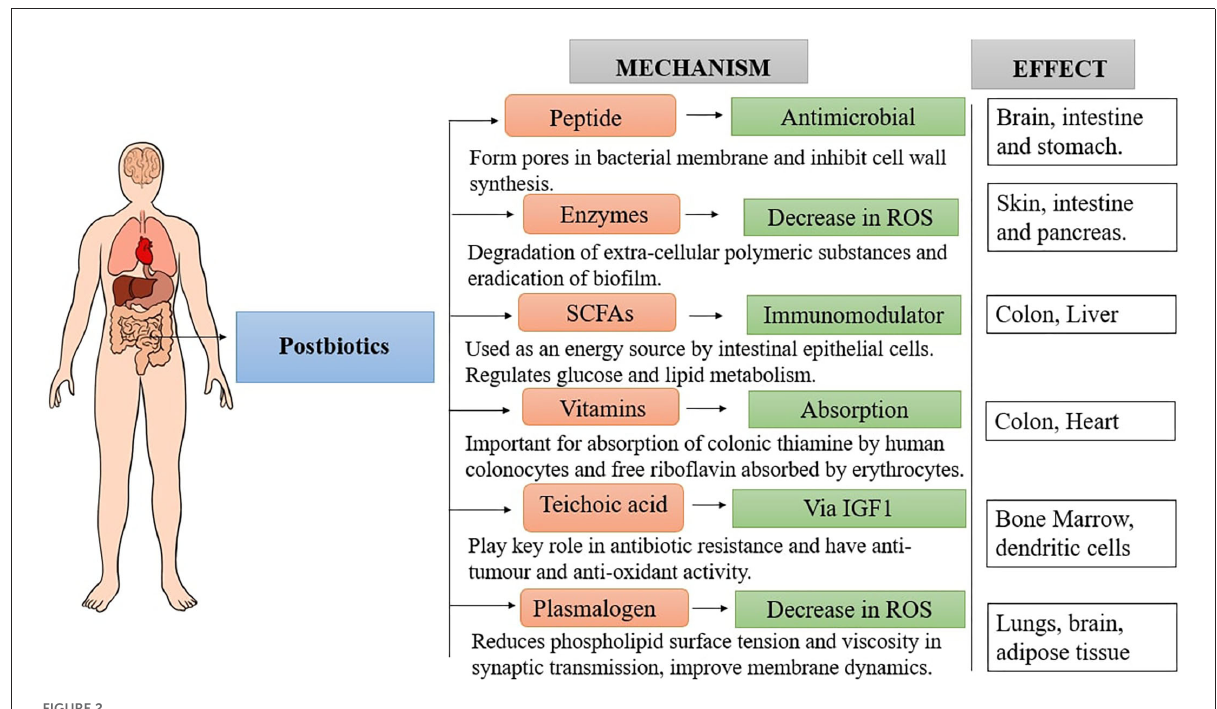
FIGURE2 Mechanism of postbiotic